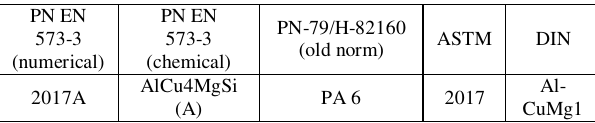
Table 1. Designation of plastic processed aluminum alloys according to selected standards [8]